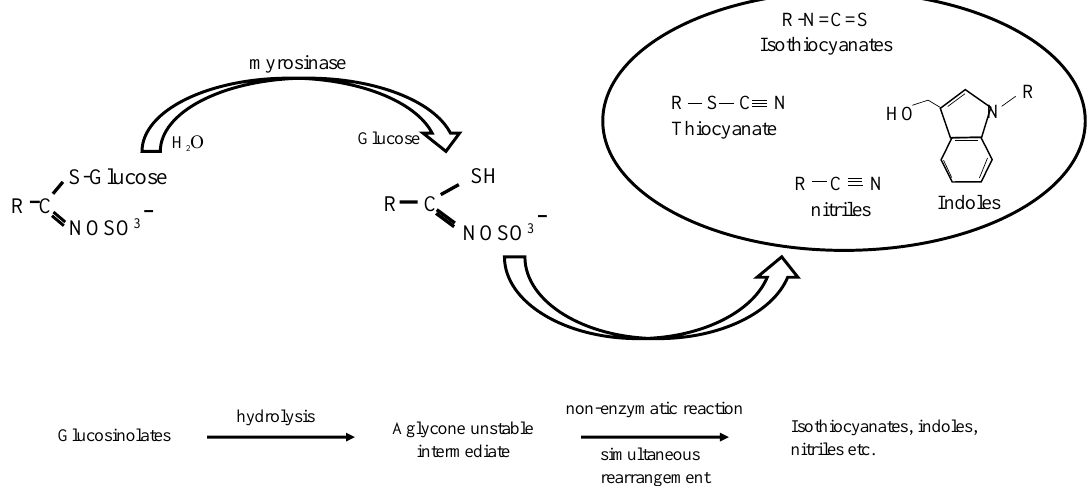
Figure 2. Hydrolysis of glucosinolates by